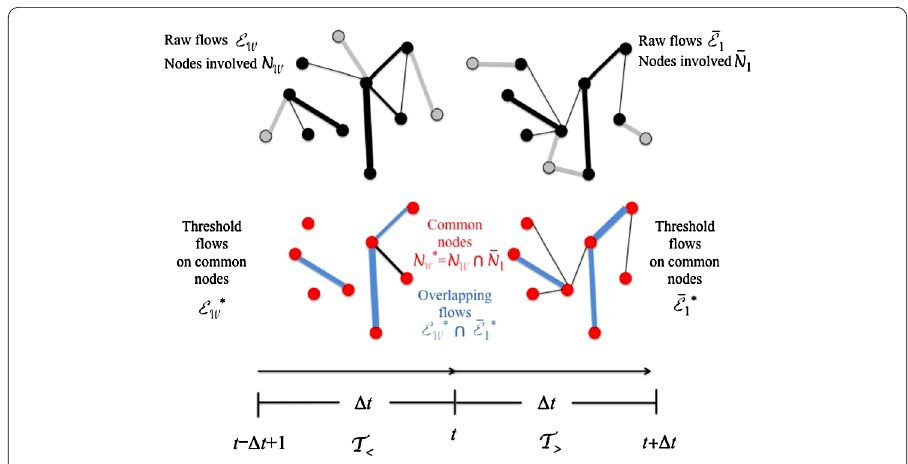
Figure 1 Illustration of the various sets defined to determine flow persistence and the usefulness of the threshold W . From the data for flows in the time period T < = [ t – (cid:2) t +1, t ], we identify those node pairs with a flow equal or exceeding W (width of lines represents flow amounts) and construct a set E W whose elements are those pairs. Similarly, in the time period T > = [ t + 1, t + (cid:2) t ] we identify node pairs with flow and build the set of pairs ¯ E 1 . The set of nodes present in the pairs E W is N W , and the set of those present in ¯ E 1 is ¯ N 1 . The common nodes (in red) are N ∗ W = N W ∩ ¯ N 1 . The node pairs of E W and ¯ E 1 that involve exclusively the nodes N ∗ W are, respectively, E ∗ W and ¯ E ∗ 1 . The intersection (in blue) E ∗ W ∩ ¯ E ∗ 1 is the set of node pairs both in ¯ E ∗ | E ∗ ∩ ¯ E ∗ | is larger than expected from E ∗ W and W 1 . Our statistical model tests whether the observed 1